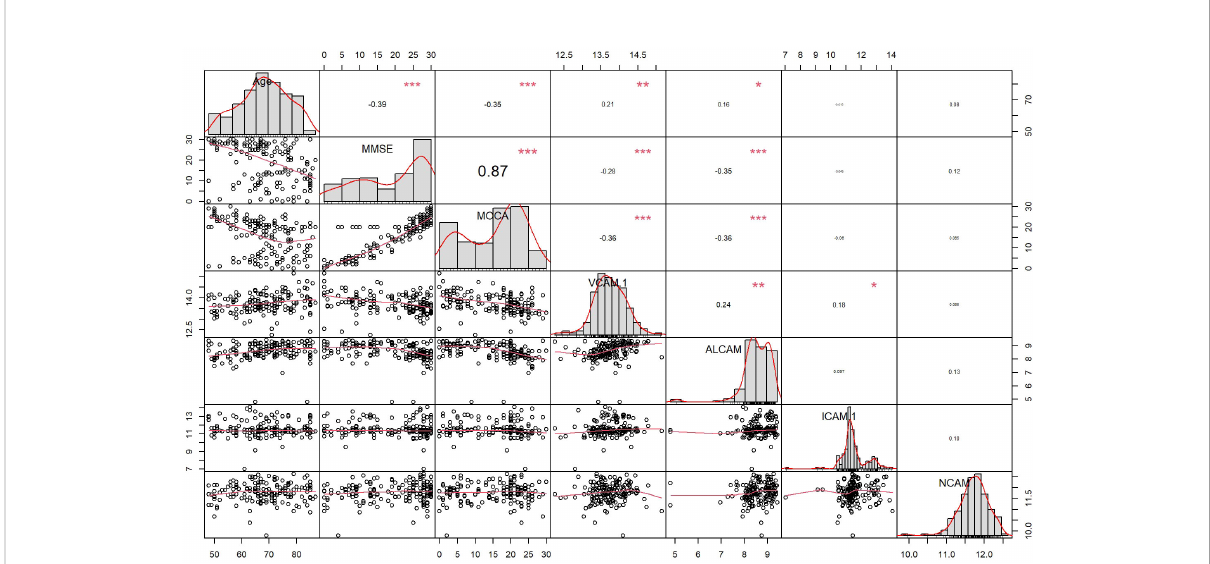
FIGURE 2 ThecorrelationbetweenfourCAMsandDemographicsdata,Cognitivetest(MMSE,MOCA)inallparticipants:Spearmencorrelationanalysisrevealeda correlationofALCAMwithAge(r=0.16,p=0.0018<0.05),MMSE(r=-0.35,p<0.001),MoCA(r=-0.36,p<0.001),whereasVCAM-1wascorrelatedwithAge (r=0.21,p=0.0085<0.05),MMSE(r=-0.28,p<0.001),MoCA(r=-0.36,p<0.001).*Thecurveatthelowerleftcornerrepresentsthe fi ttingcurveoftwofactors,